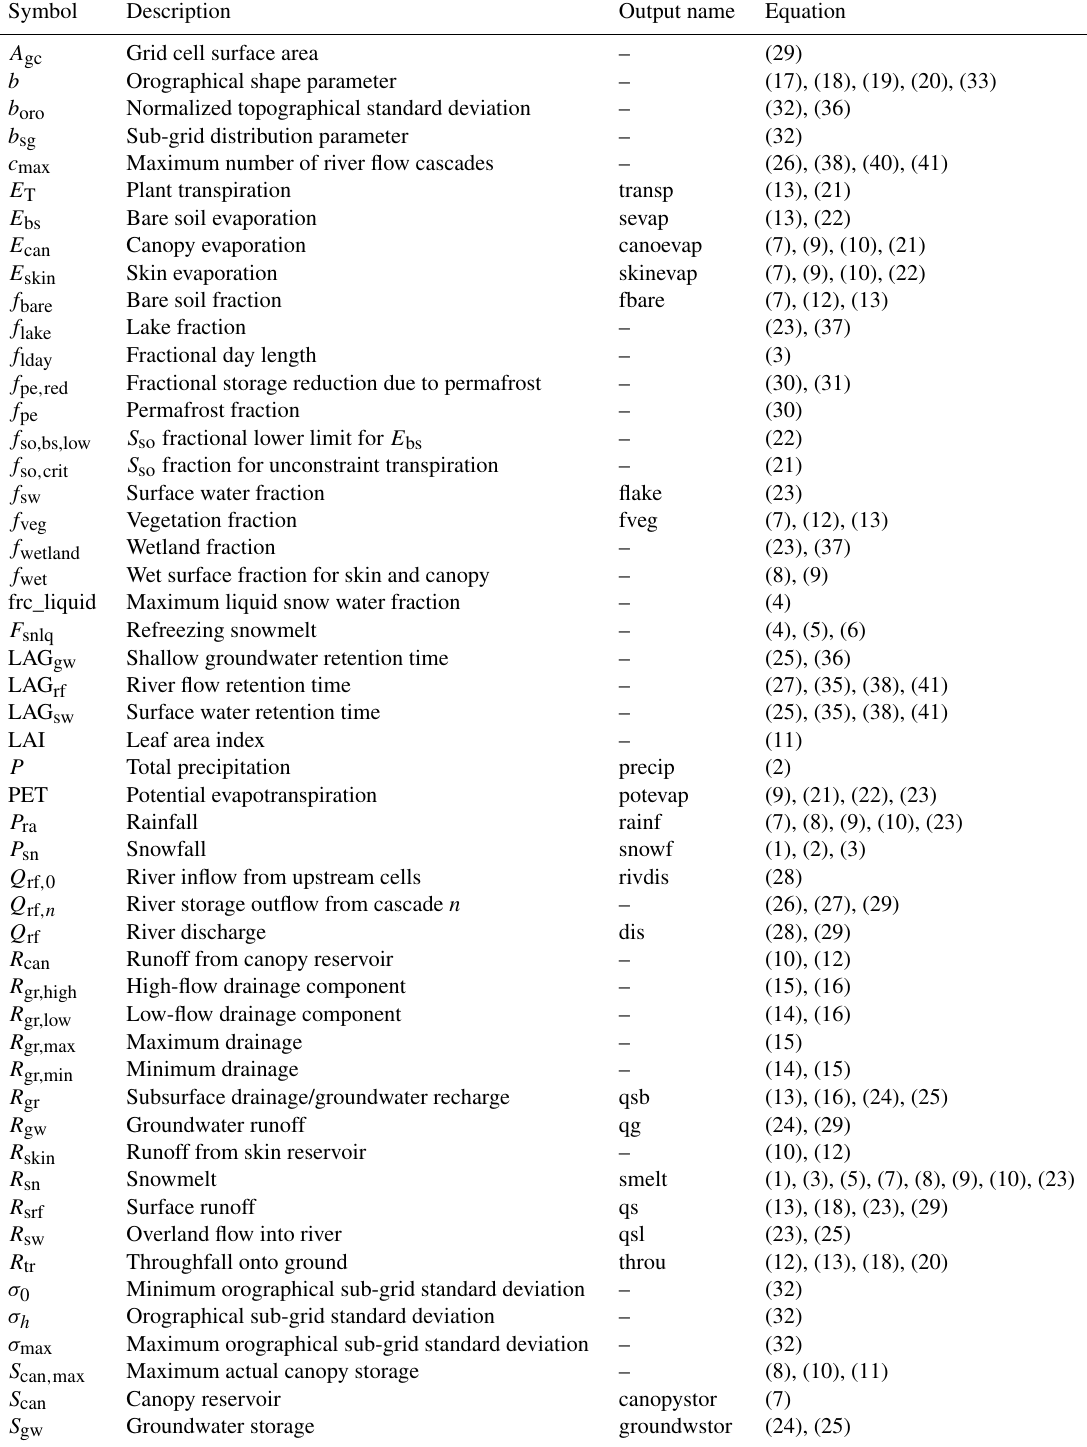
Table 1. Overview of variables used in HydroPy process description, referenced with their equation numbers. Variables directly available for output are denoted by providing their short name in the output